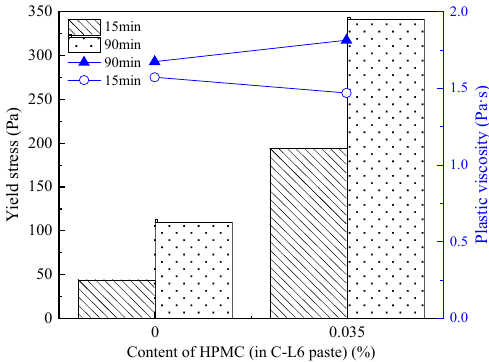
Figure 20. Yield stress and plastic viscosity of C-L6-R1.0-HPMC pastes. Compared with the τ 0 of C-L6-R1.0 and C-L6-HPMC pastes, it can be clearly seen